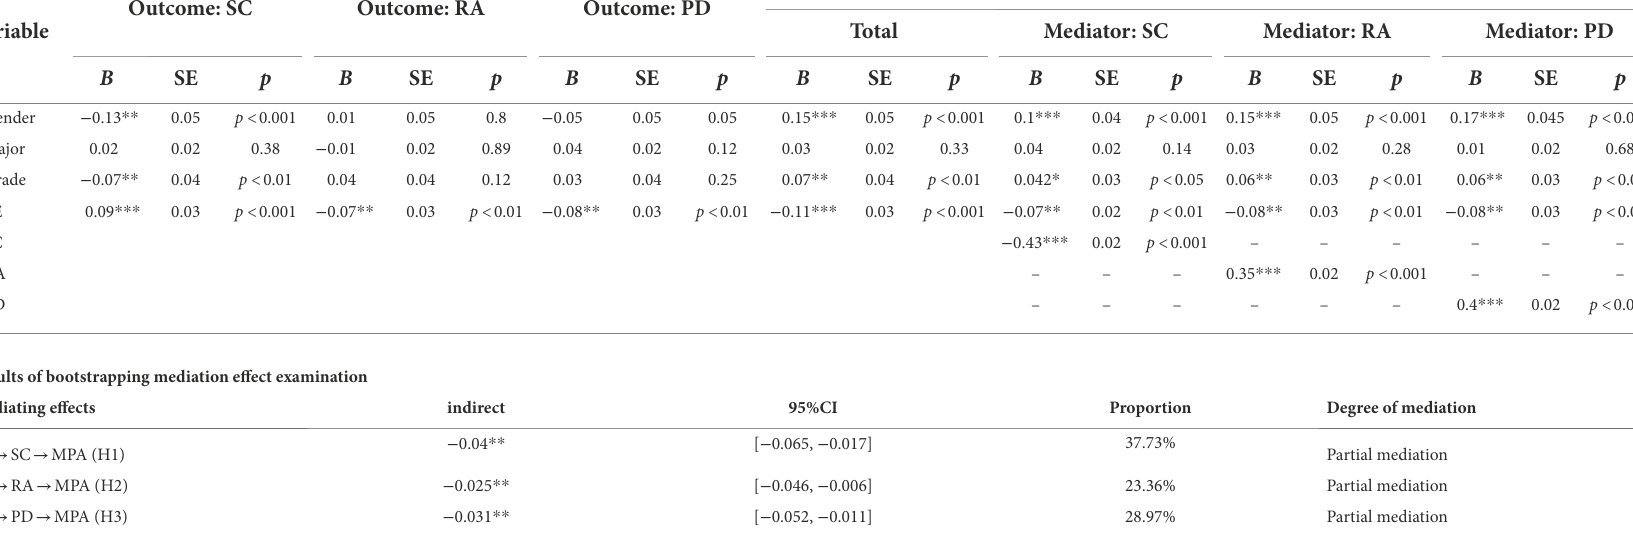
Outcome: SC Outcome: RA Outcome: Variable